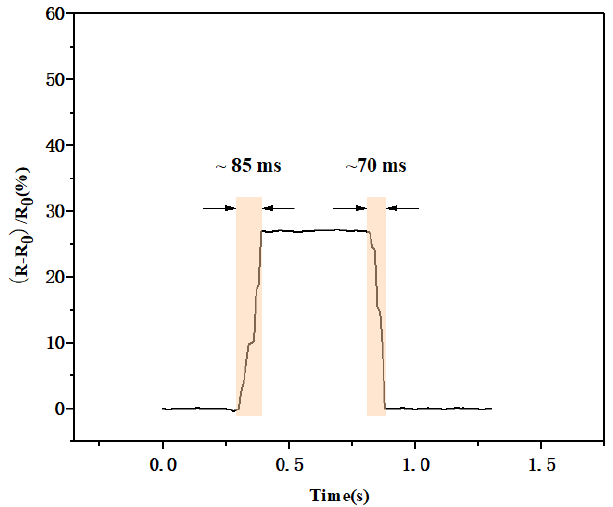
Figure 11. Response time of the flexible pressure sensor when exposed to external pressure.